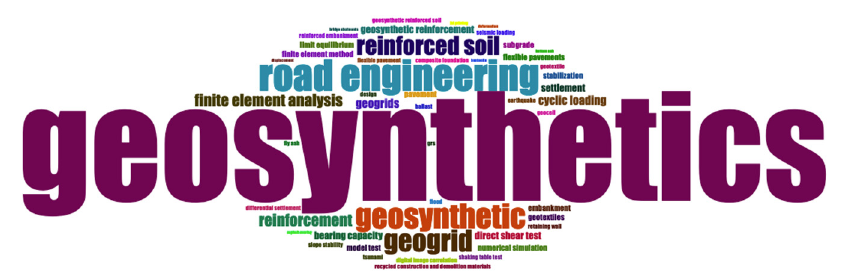
Figure 22. Word Figure 22. Word clouds. Figure 22. Word clouds.